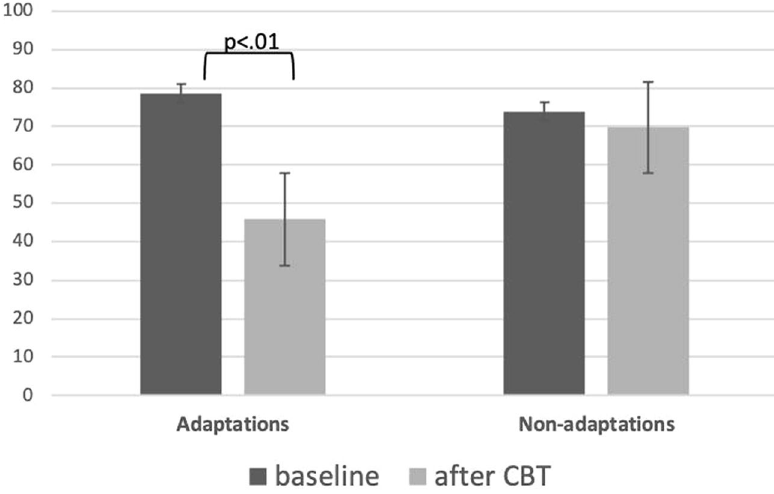
Figure 1. VAS value after the CBT intervention. The U-test was used to analyze the average difference in pre- and post-CBT VAS score for low back pain. After 10 sessions, there were 18 patients with improvement in the VAS score for low back pain (78.50 ± 15.31 → 45.87 ± 16.40). Further, there were 28 patients without improvement in the pain VAS score (73.80 ± 17.78 → 69.70 ± 16.78). Thus, we confirmed a VAS score improvement in 39.13% of all patients.